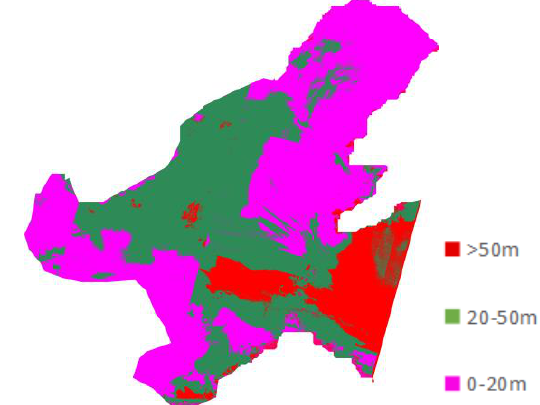
Figure 2 .Bathymetry estimation results from Landsat 8 data multi-band statistical model. The average absolute error of the model in the water depth of 10-20 m is 1.48 m. The average relative error is 13.12%. It should